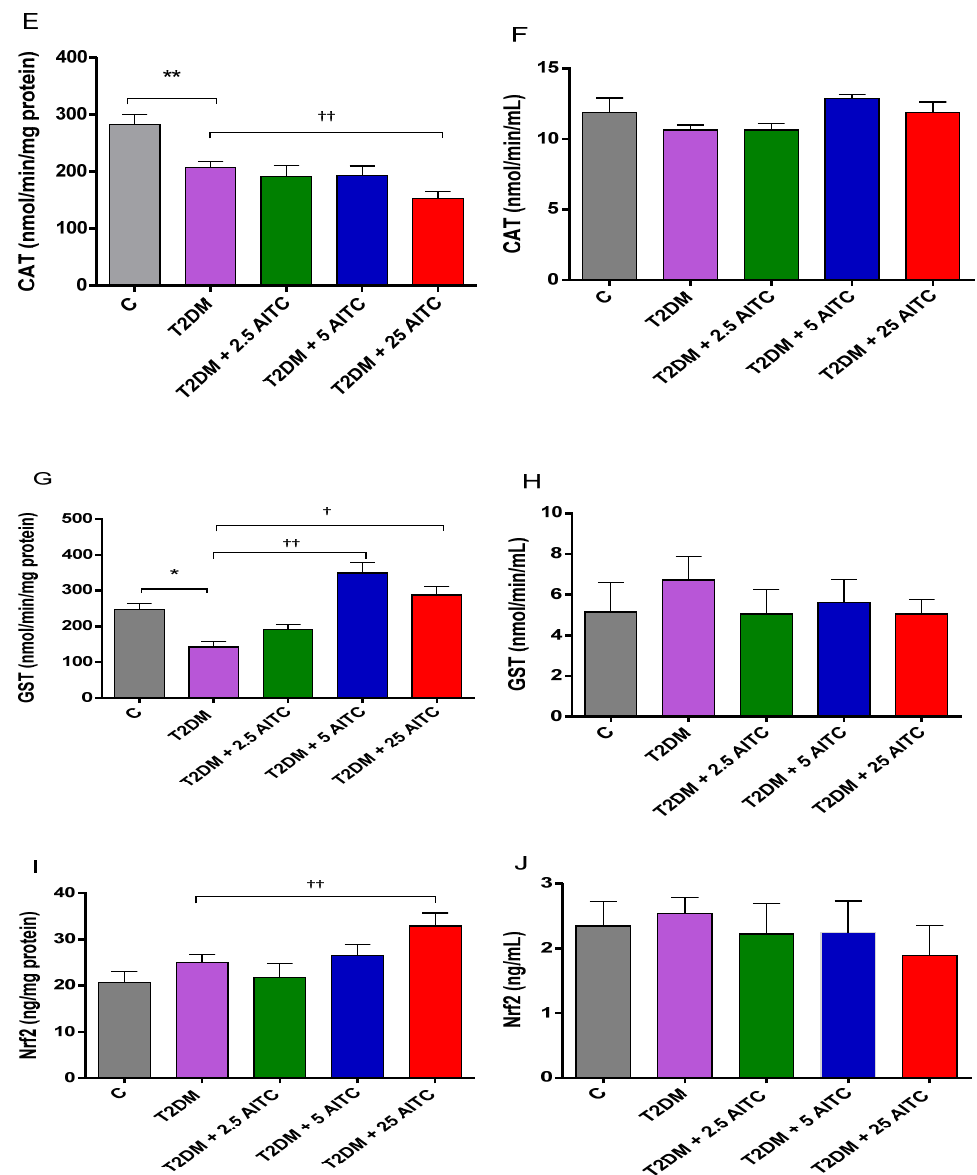
Figure 1. Effects of AITC on antioxidant enzyme activities: SOD ( A , B ), GPx ( C , D ), CAT ( E , F ), GST ( G , H ) and Nrf2 transcription factor contents ( I , J ) in the liver and the blood serum of diabetic rats. Each column represents the mean ± SEM ( n = 8). * p ≤ 0.05, ** p ≤ 0.01, *** p ≤ 0.001 compared with C group; † p ≤ 0.05, †† p ≤ 0.01, ††† p ≤ 0.001 compared with T2DM group. Abbreviations: C—control group; T2DM—high-fat diet with STZ-injected group; T2DM +AITC 2.5; AITC 5; AITC 25—high-fat diet with STZ-injected group with oral administration of 2.5; 5; 25 mg/kg b.w. AITC,